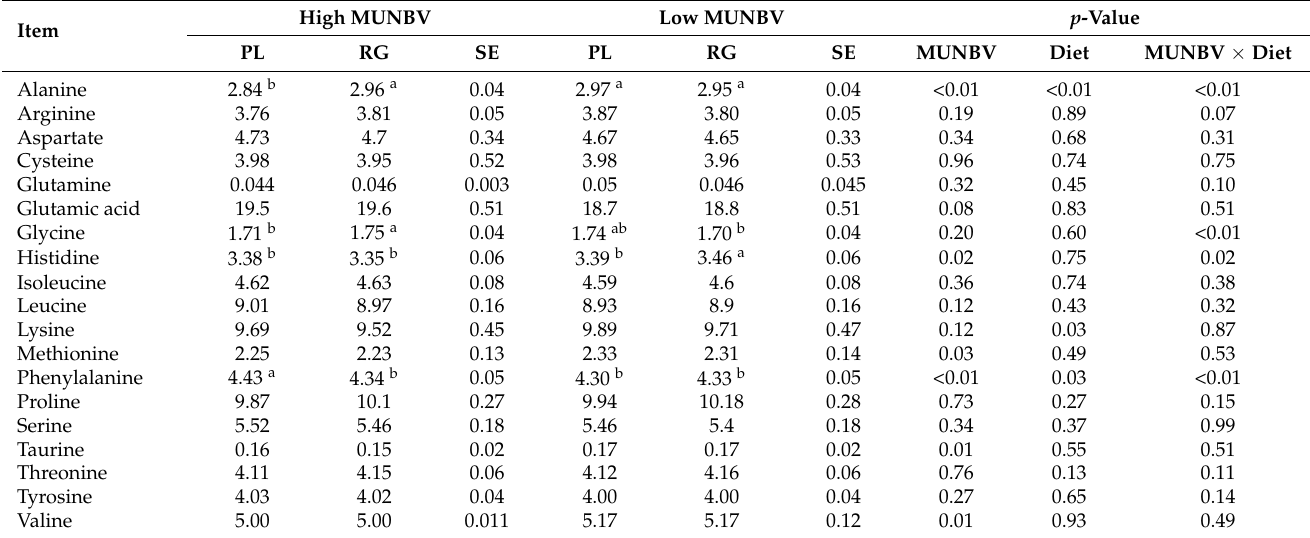
Table 3. The relative proportion of milk amino acid for cows considered divergent for milk urea nitrogen breeding values (MUNBV) consuming a diet of either plantain (PL) or ryegrass